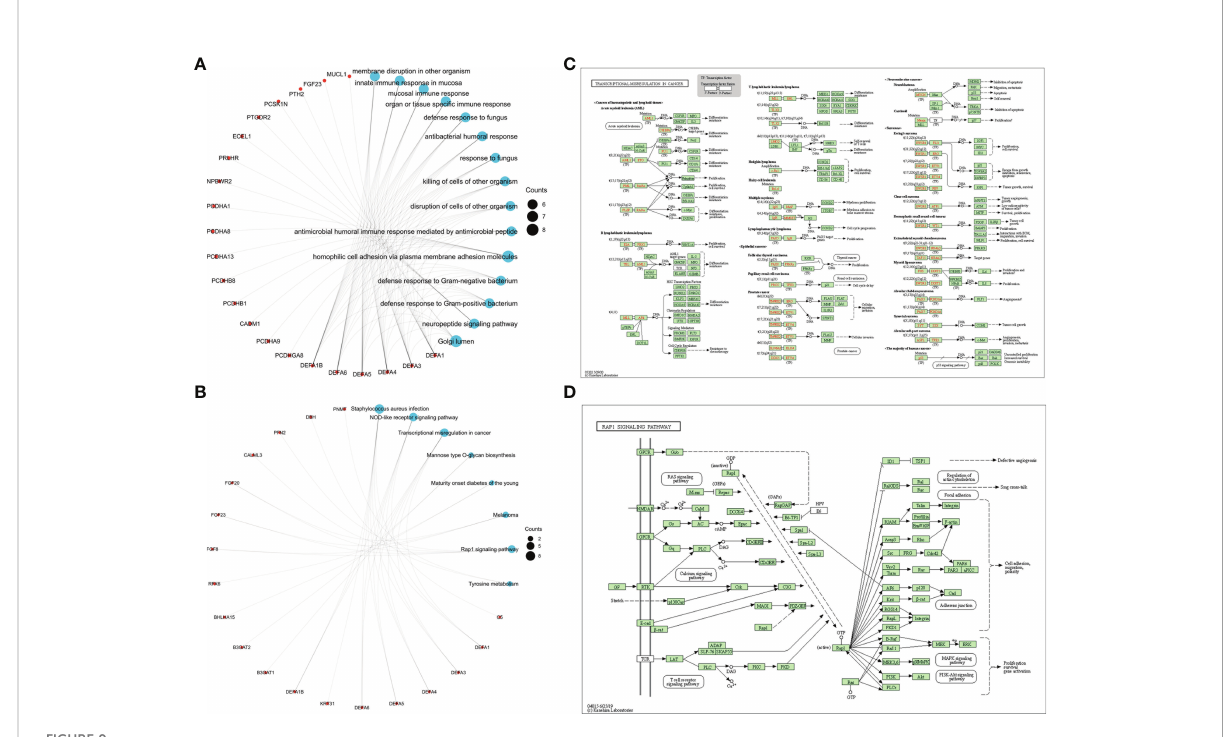
FIGURE 9 Enrichment Network and pathways of DEFAs. (A) Enrichment Network of DEFAs (GO); (B) Enrichment Network of DEFAs (KEGG); (C) Transcription Disorders Signaling Pathway; (D) Rap1 Signaling Pathway.